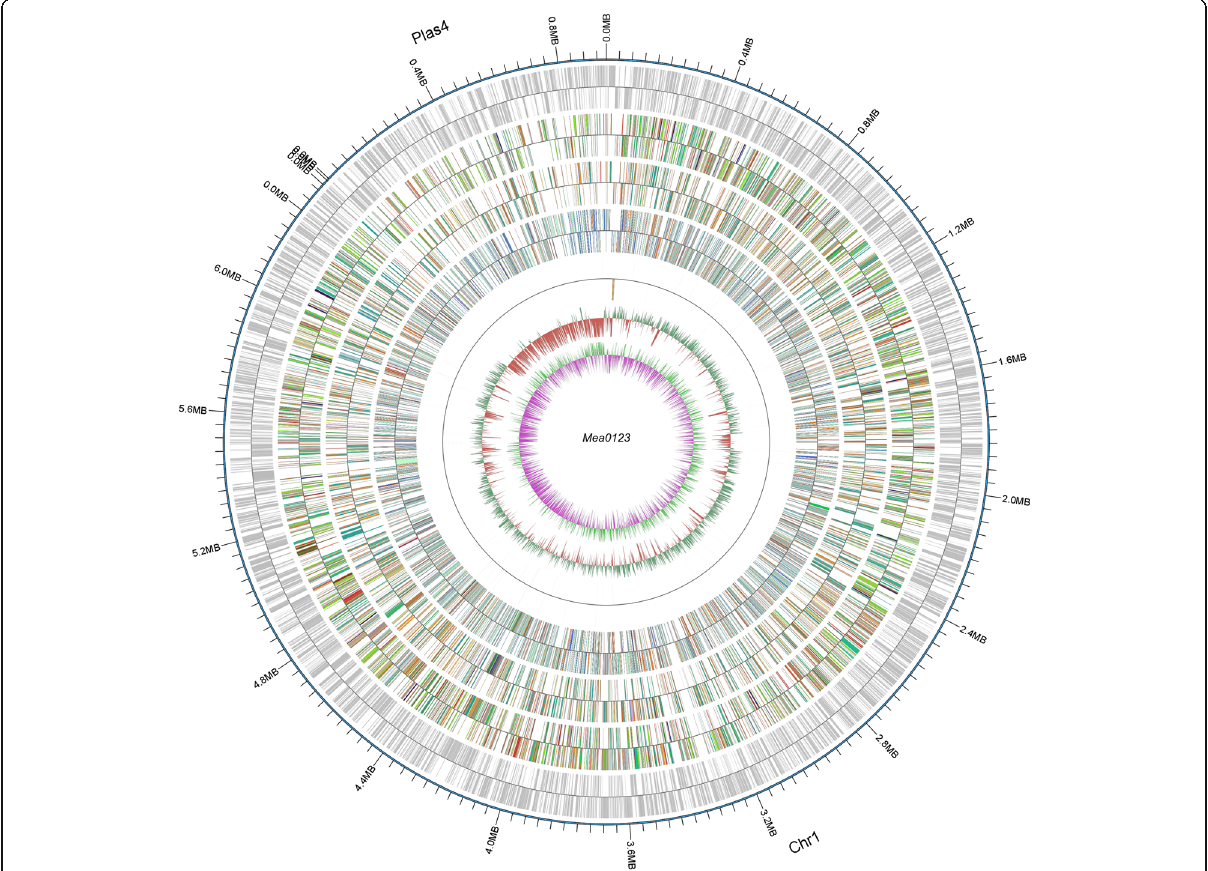
Fig. 3 Graphical map of Mesorhizobium amorphae CCNWGS0123 genome. From outside to the center: sequence position coordinates, coding gene, COG assignment, KEGG assignment, GO assignment, ncRNA, G + C content and G + C